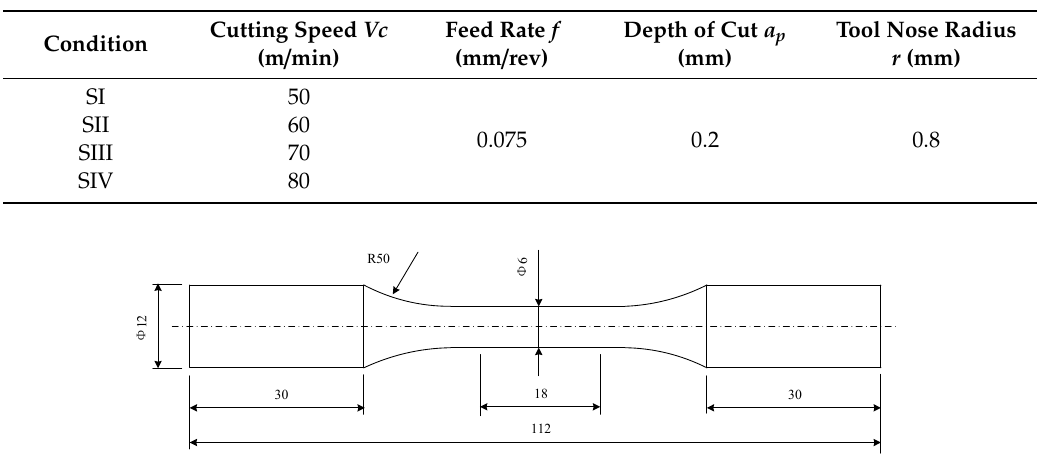
Bal Table 2. Tensile mechanical properties of the material at room temperature [22]. Elastic Modulus